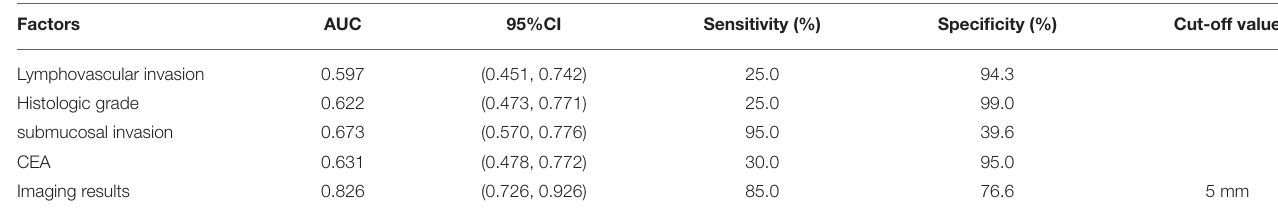
TABLE 3 | Independent risk factors for LNM in T1 colorectal cancer of ROC